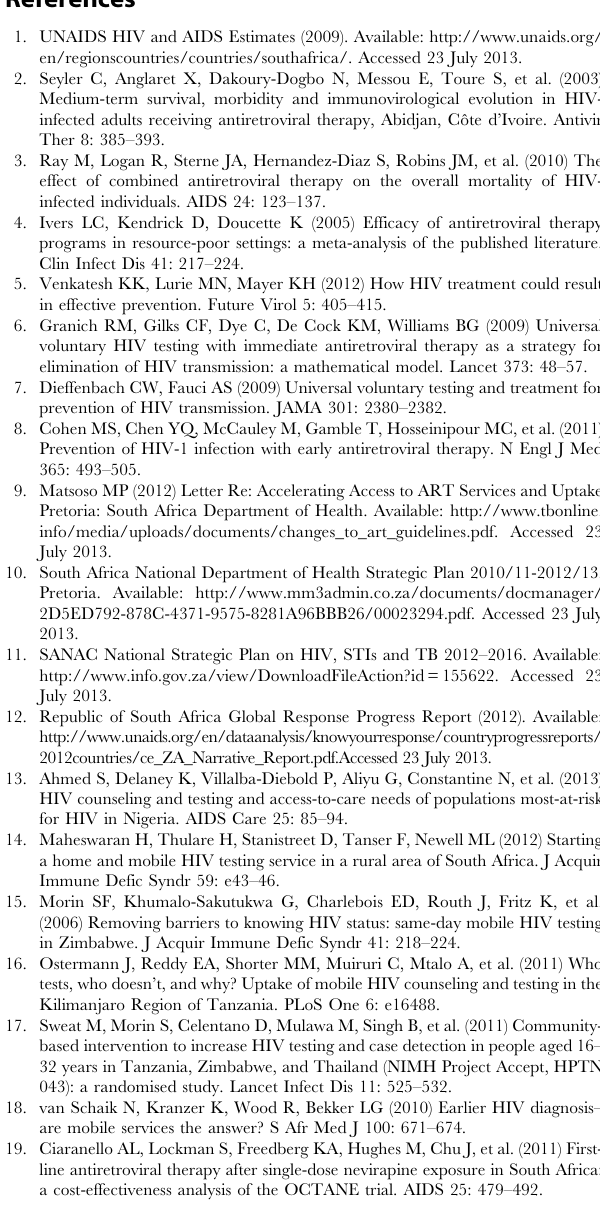
Figure S2 Two-way sensitivity analyses on mobile unit test acceptance and linkage to care. This diagram shows the incremental cost-effectiveness of the addition of mobile unit HIV testing to medical facility-based testing under conditions of varied mobile unit test acceptance and linkage to care. Linkage to care is varied on the vertical axis and test acceptance is on the horizontal